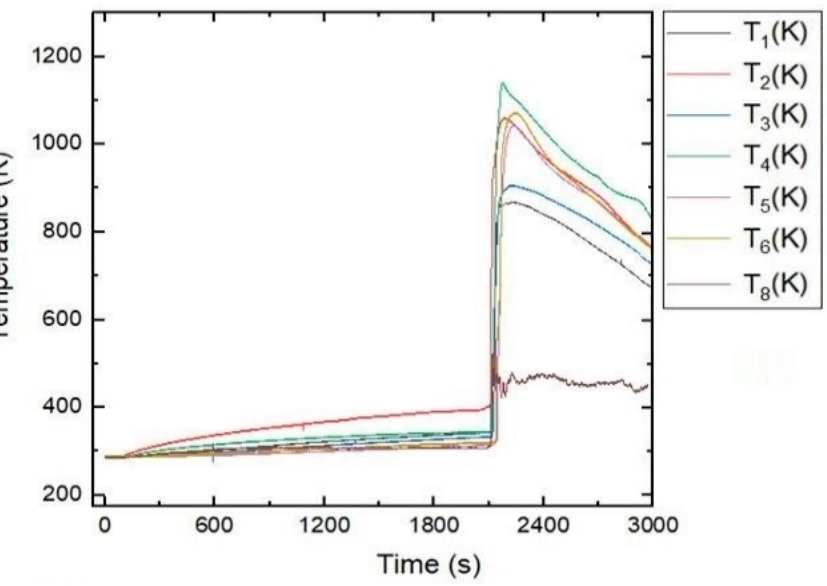
Figure 3. Temperature profile of the battery stack (Test